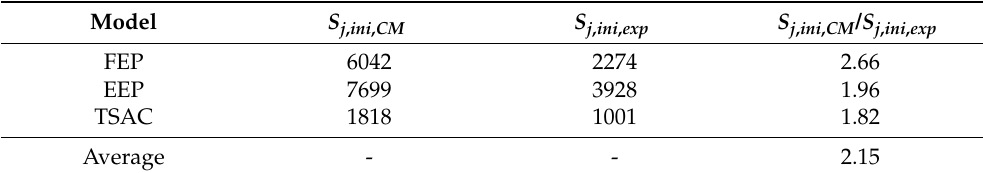
Table 3. Comparison of the initial rotational stiffness evaluated with the component method, S j , ini , CM , and the method of Zanon and Zandonini [42] from the experimental curves (Figure 8), S j , ini , exp , (Unit: kNm/rad).